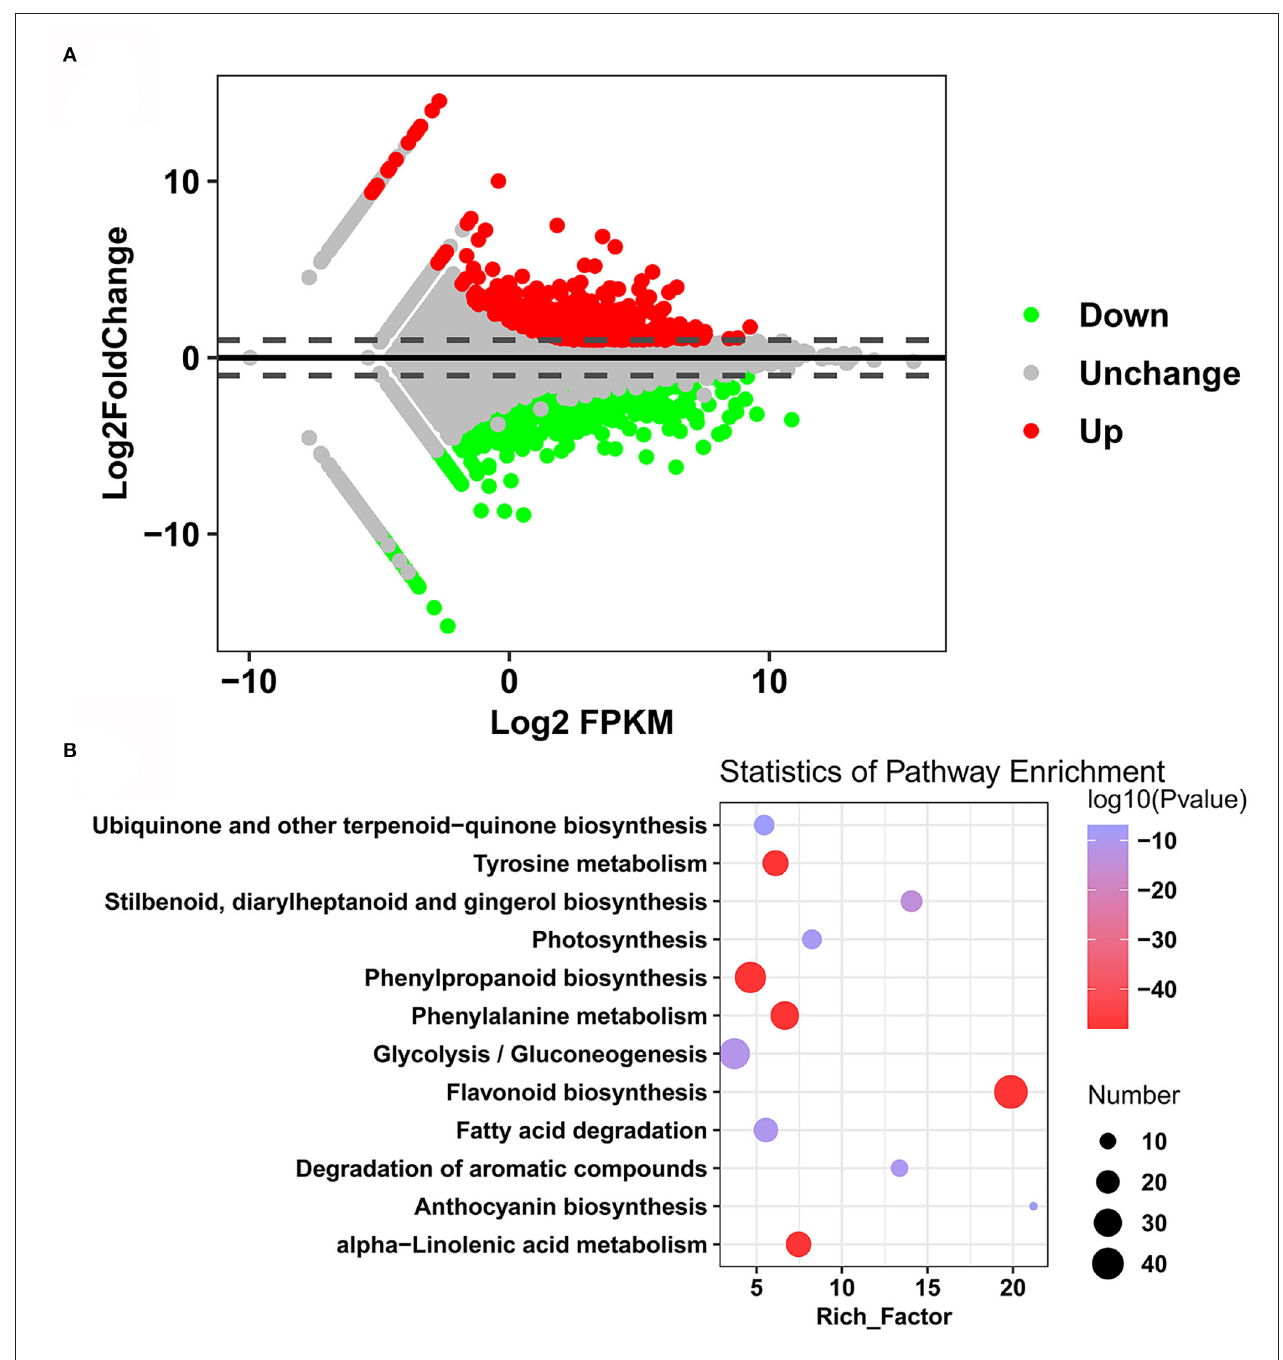
FIGURE 5 | DEGs and KEGG enrichment analyses of roots of Xuzi201 and M1001. (A) M-vs.-A plot (MA) displaying the upregulated, downregulated, and unchanged expression genes between Xuzi201 and M1001. Horizontal coordinates are Log 2 FPKM of expression genes, and vertical coordinates are Log 2 fold change of expression genes. The red, green, and black dots represent the genes expression upregulated, downregulated, and unchanged. (B) Top 12 KEGG enrichment terms of differentially expressed genes. The horizontal coordinate indicates the rich factor of each pathway, the vertical coordinate is the name of the pathway, and the color of the dot is the P -value; the redder it is, the more significant the enrichment. The size of the dots represents the number of differential metabolites enriched.